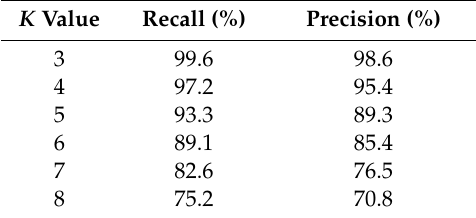
Table 2. The retrieval result of di ff erent K (reduced dimension of horizontal group = 1).